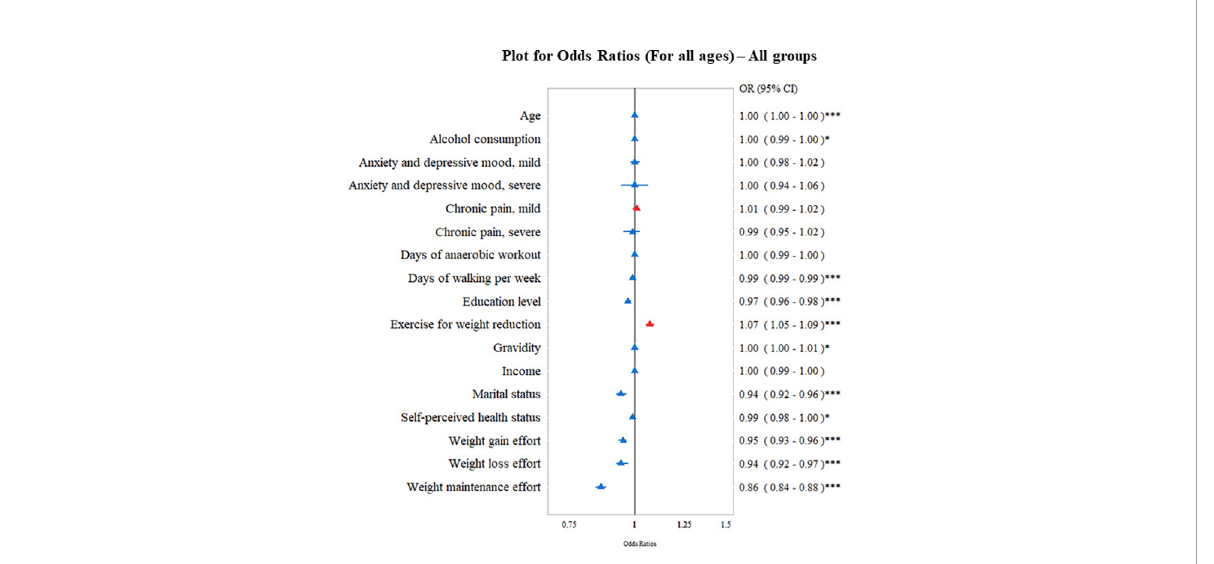
FIGURE 2 Study participants showing odds ratio (OR; 95% con fi dence interval [CI]) of socioeconomic and health-related factors associated with overall body weight misperception (either overestimation or underestimation). * P < 0.05, *** P <